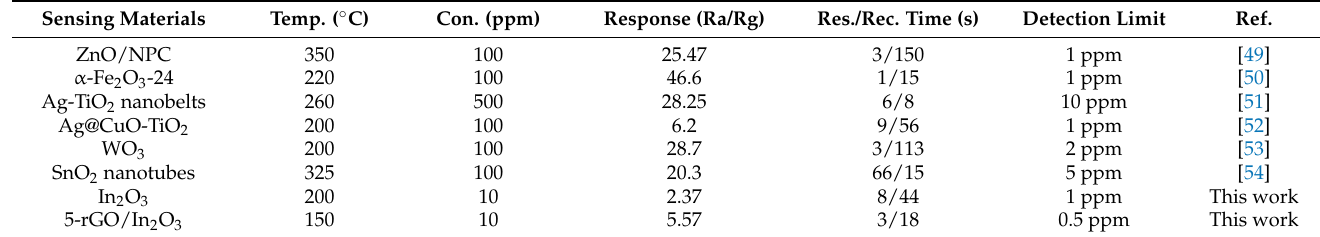
Table 1. Comparison of sensing properties for acetone